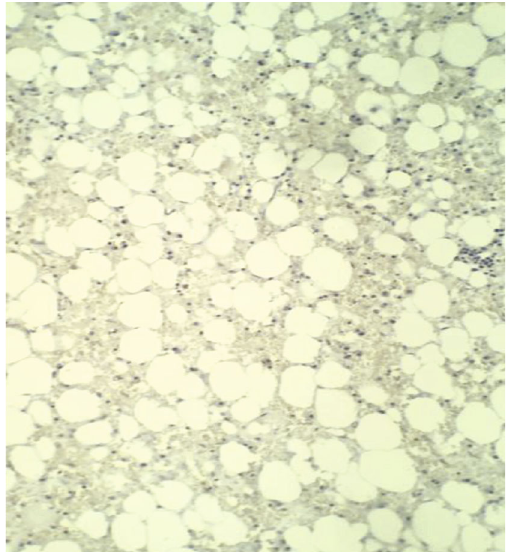
Figure 4: Immunohistochemistry showing the absence of expression of the MDM2 protein,